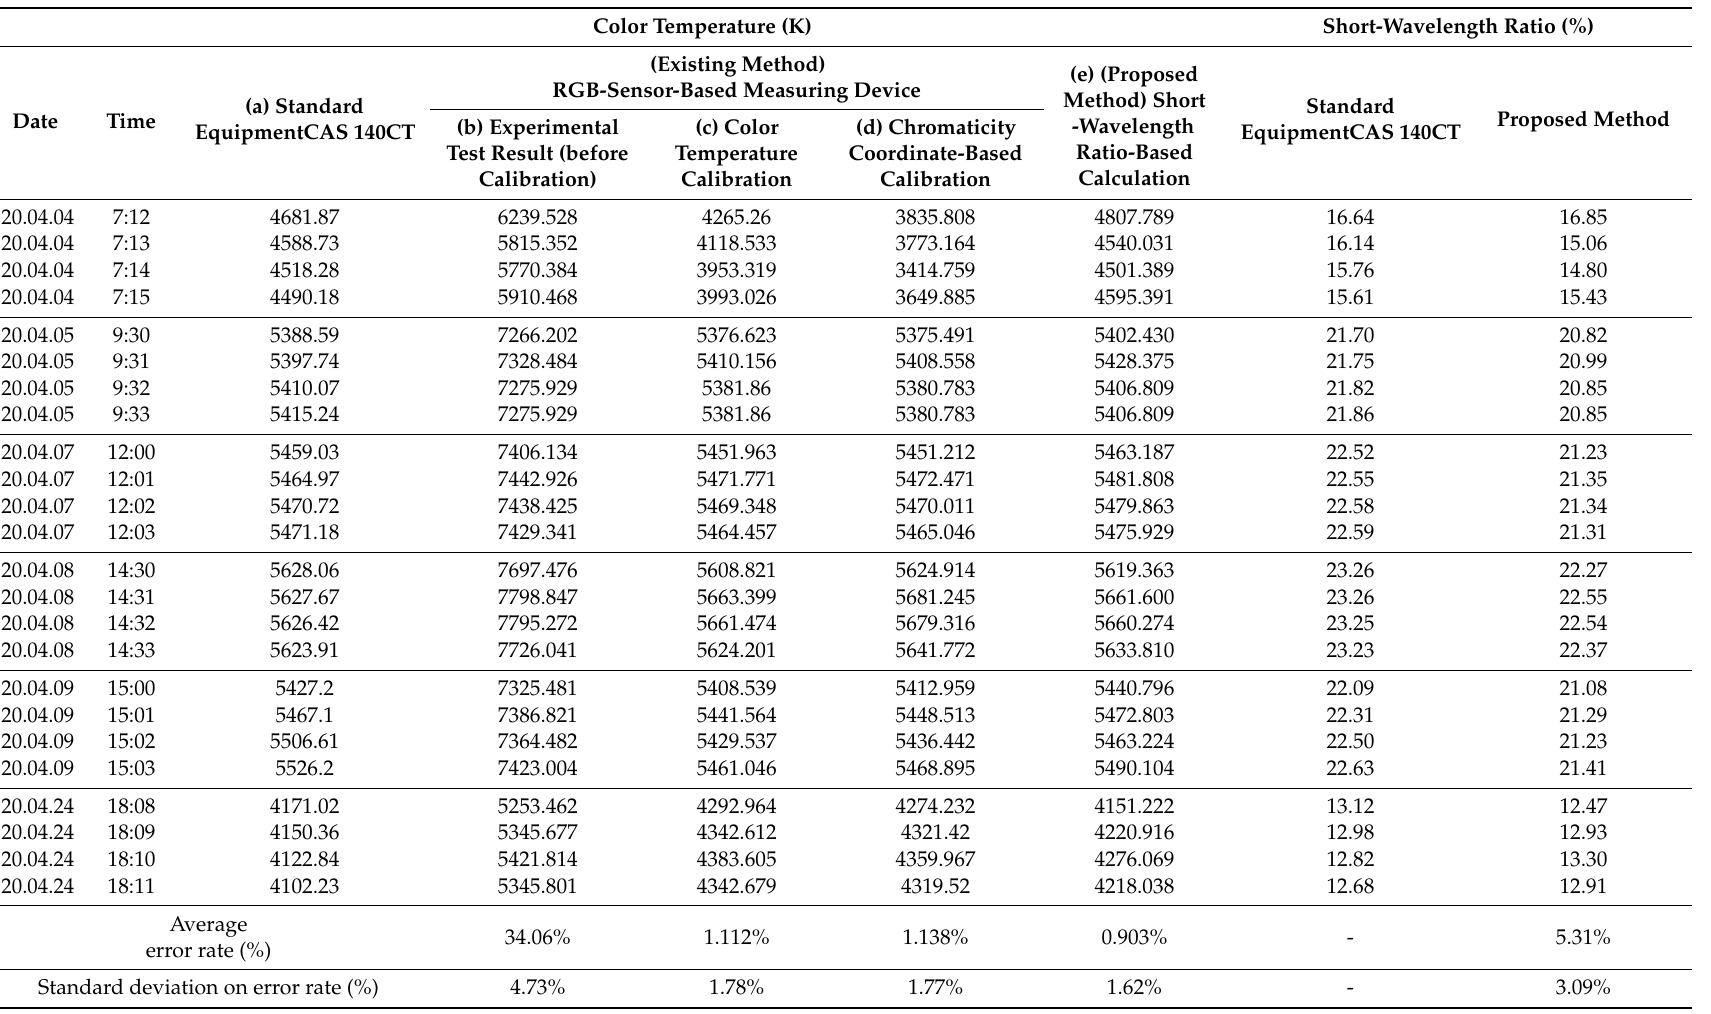
Table 6. Comparison of color temperature measurement and calculation